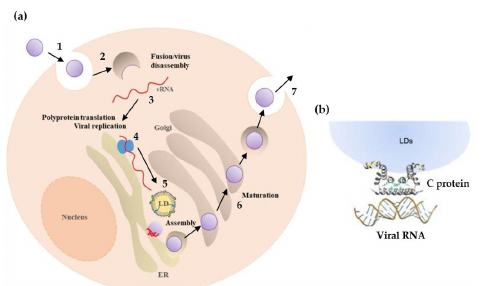
Figure 2. Flavivirus life cycle, highlighting the capsid protein role. ( a ) Flavivirus life cycle. The virion enters the host cell by clathrin-mediated endocytosis (1). Fusion of the viral envelope and the cell membrane is promoted by acidification of the endosome (2), followed by the viral genome release into the cytoplasm (3). The viral genome is translated into a polyprotein that is cleaved into 10 proteins: three structural and seven non-structural (4). Next, replication occurs surrounding the ER and LDs (5). This process is followed by virus packaging and assembly, to form new infectious viral particles (6) that follow a secretory pathway, being released through exocytosis (7). ( b ) The C protein interacts with host LDs and the viral genome, interactions that are crucial for DENV replication and genome packaging, respectively. Those interactions might be targeted in future therapeutic strategies. Adapted from [69,76].